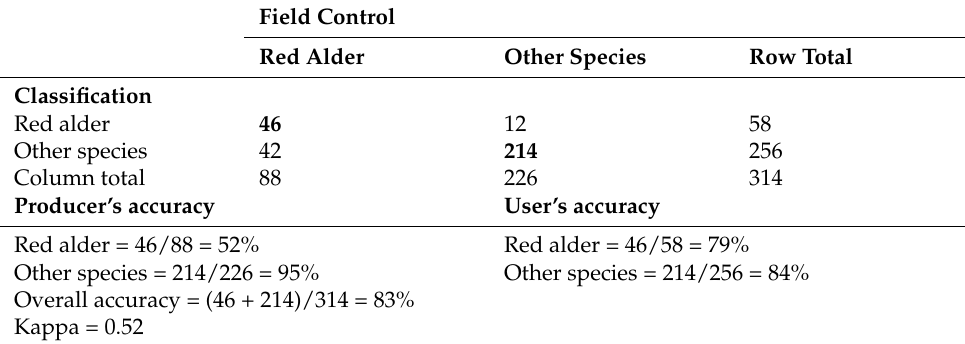
Table 10. Confusion matrix for red alder trees using the smoothed watershed segmentation. Species were modeled with variability in canopy steepness and mean return intensity. Segments were classified using a logistic generalized linear mixed model with a plot held as a random effect.